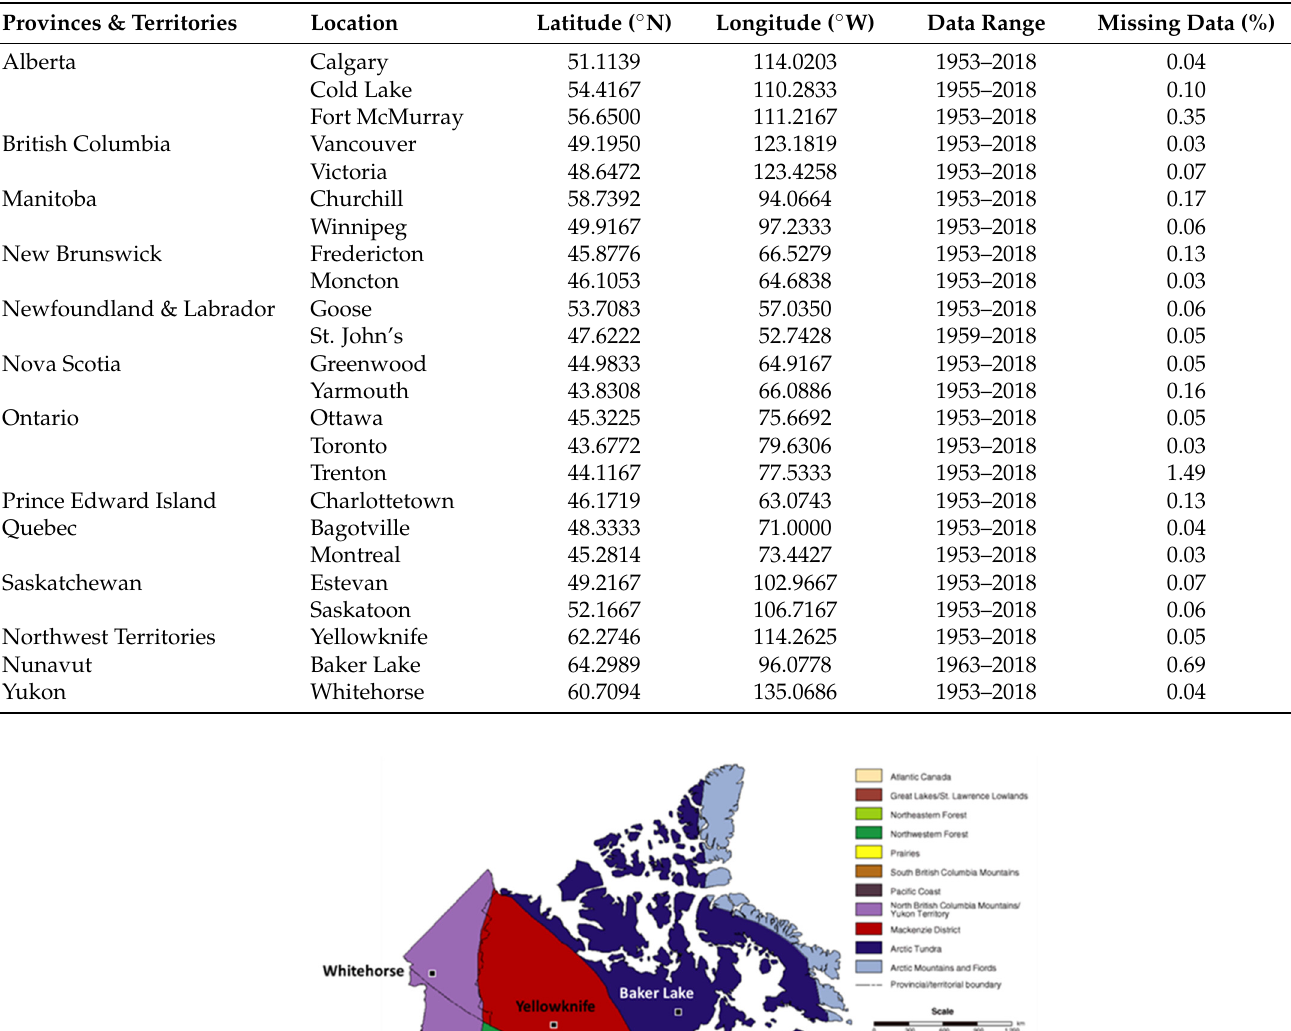
Table 1. List of weather stations used in the study. All temperature data examined in this study represent hourly measurements obtained from Canadian international or regional airports using consistent observation standards. Hourly temperature data range from the year 1953 to 2018 for most stations.